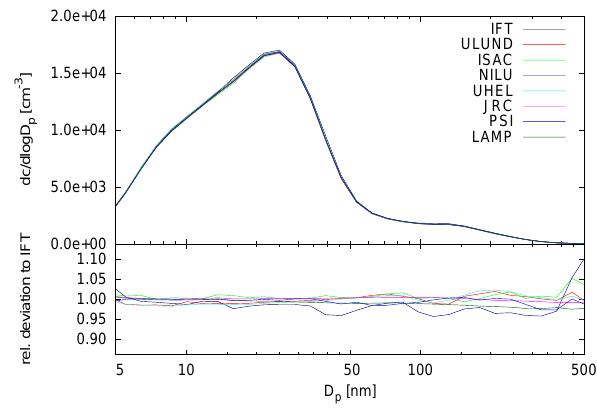
Fig. 2. Comparison of the performance of eight different multiple- charge inversion routines. Shown are the different resulting PNSDs based on the very same EPMD and their relative deviation to the new inversion routine. Reproduced from Wiedensohler et al.